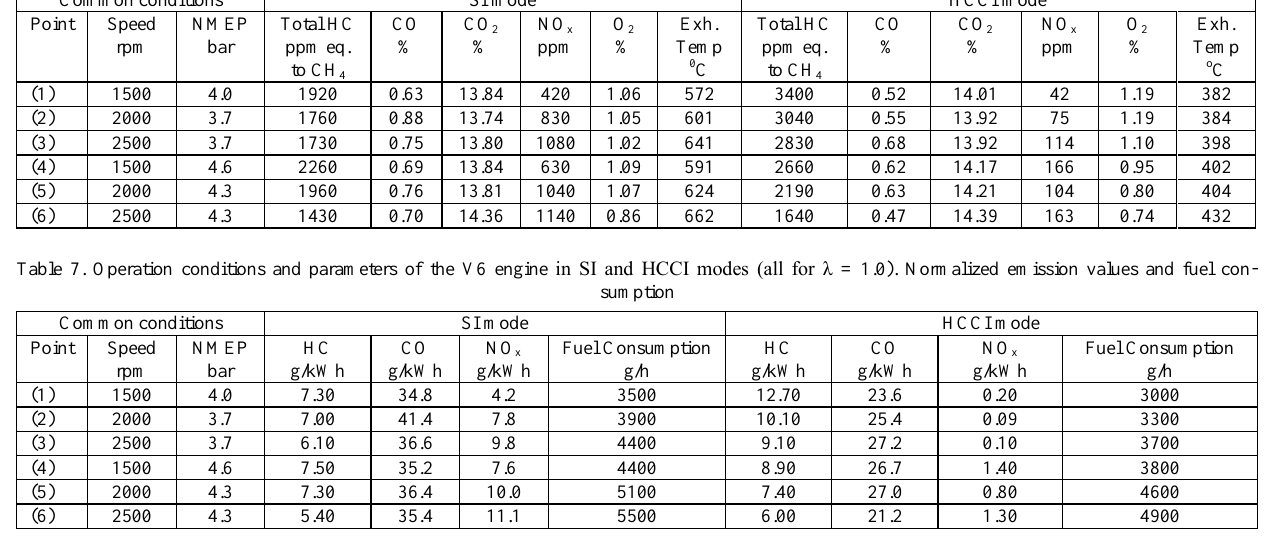
Table 6. Operation conditions and parameters of the V6 engine in SI and HCCI modes (all for λ = 1.0) Common conditions